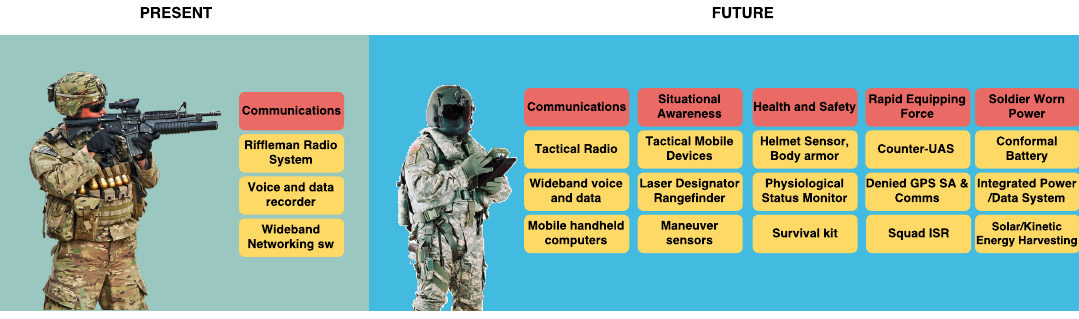
Figure 4. Soldiers of today and the